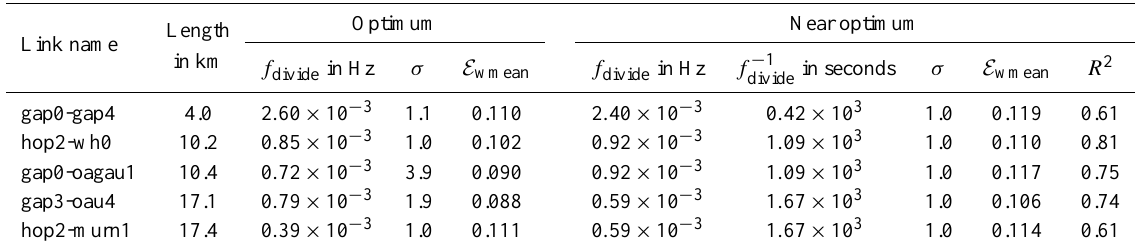
Table 4. Resulting mean error rate E mean of the wet dry classification algorithm with the corresponding optimum values (also depicted in Fig. 5) of σ and f divide . Also listed are the near optimum values for which f divide follows the reciprocal of the link length (see text for details) and σ = 1. For comparison with the link length, the reciprocal of f divide is given. The correlation coefficients R 2 stem from the comparison of the link-derived rain rates with rain gauge data in section 7 using the near optimum values. A window length of 256min was used in the underlying